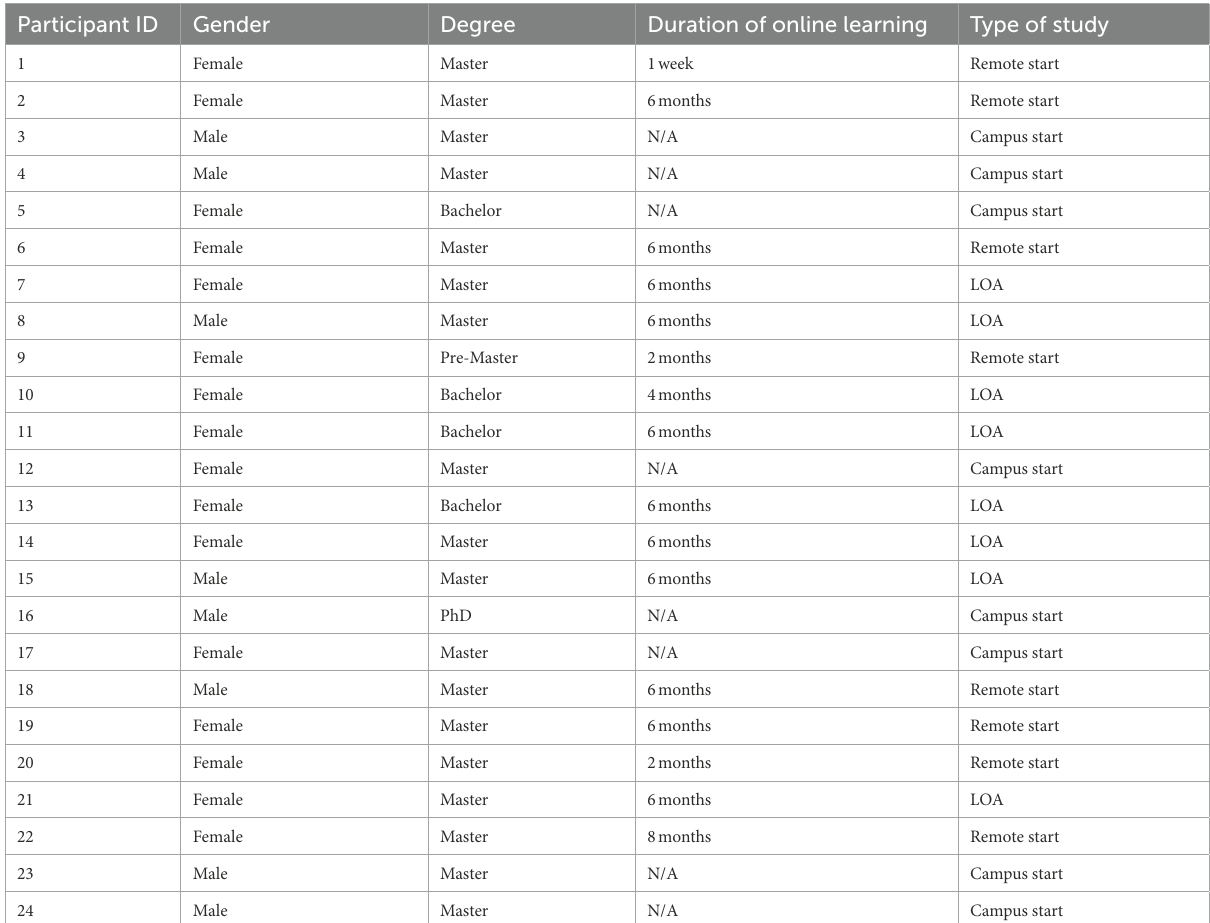
TABLE 1 Participant